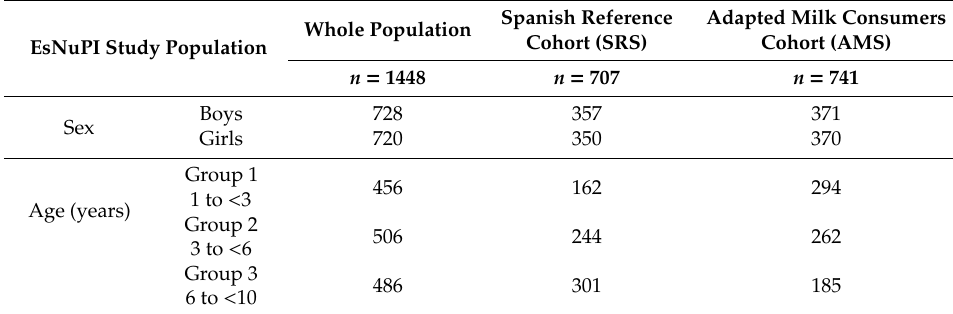
Table 1. Distribution of studied cohorts in the Nutritional Study in the Spanish Pediatric Population (EsNuPI) ( n =